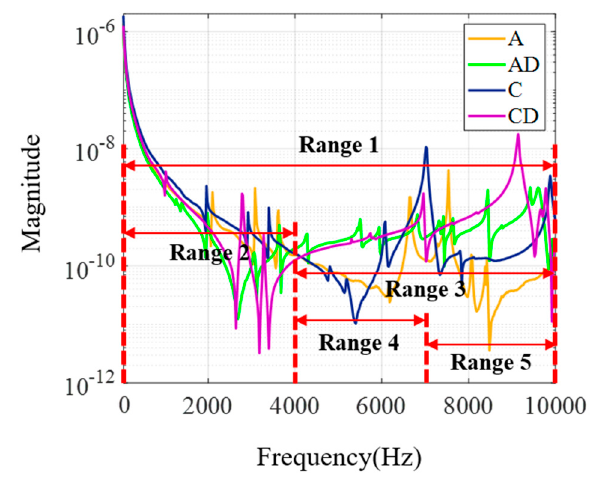
Figure 6. Division of frequency range for feature extraction.